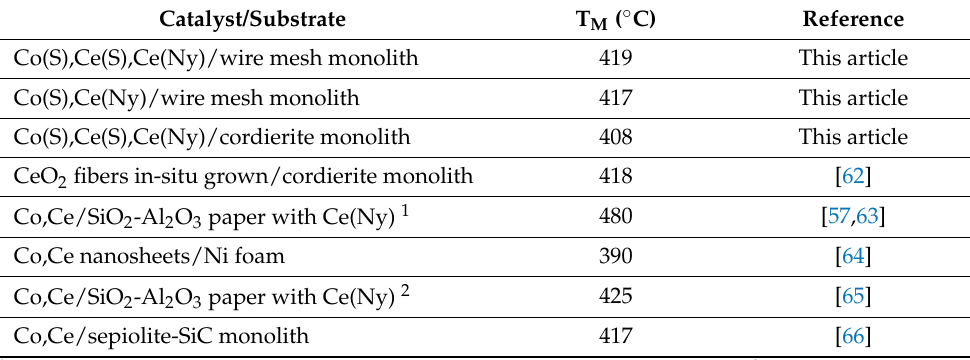
Table 4. A comparison of the catalytic activity of the best catalysts here reported with other good catalysts for soot combustion.